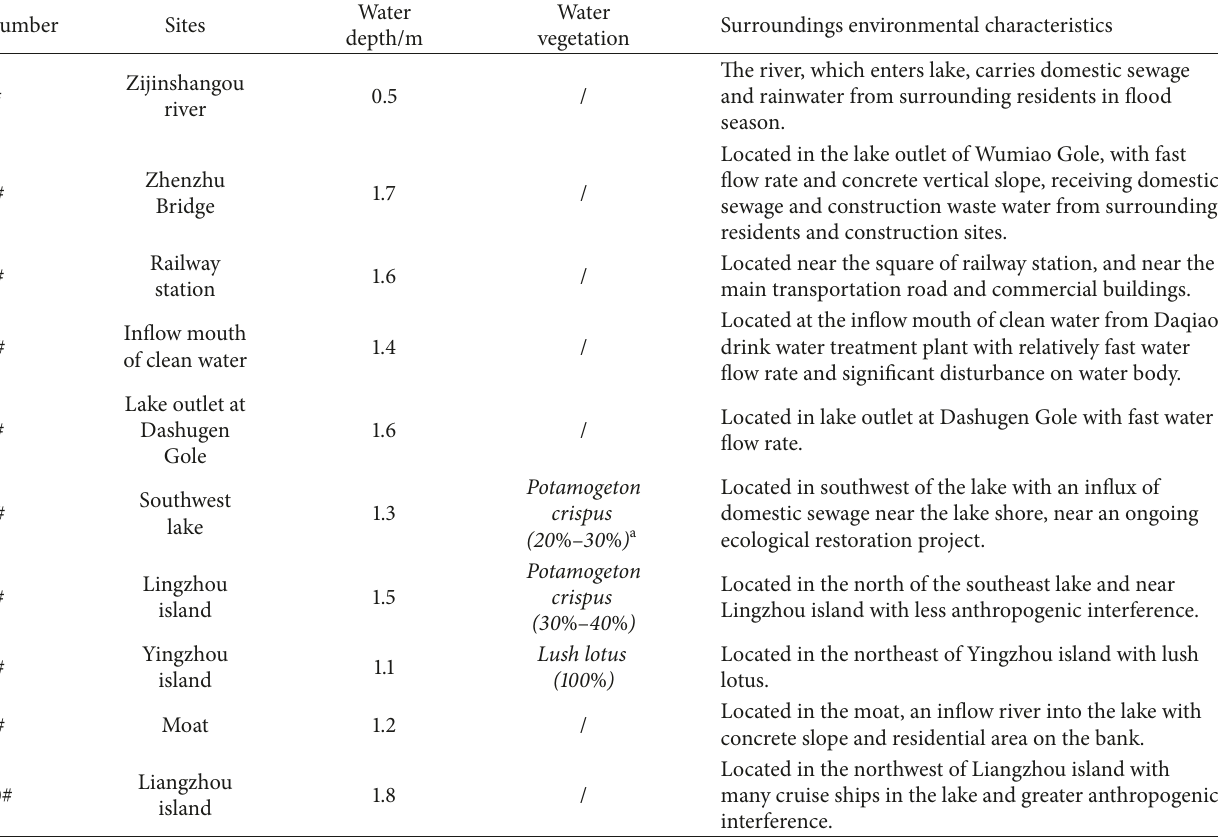
Table 1: The code of sampling sites and their surrounding environmental